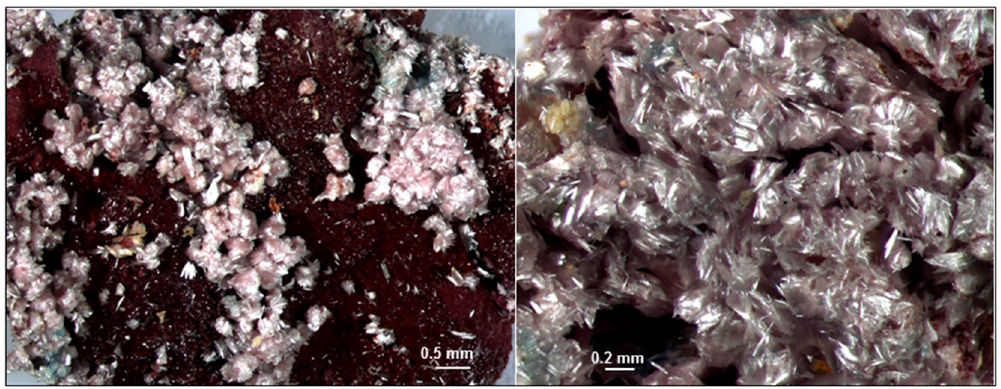
Figure 10. Stereomicroscope images of fibroferrite over hematite.